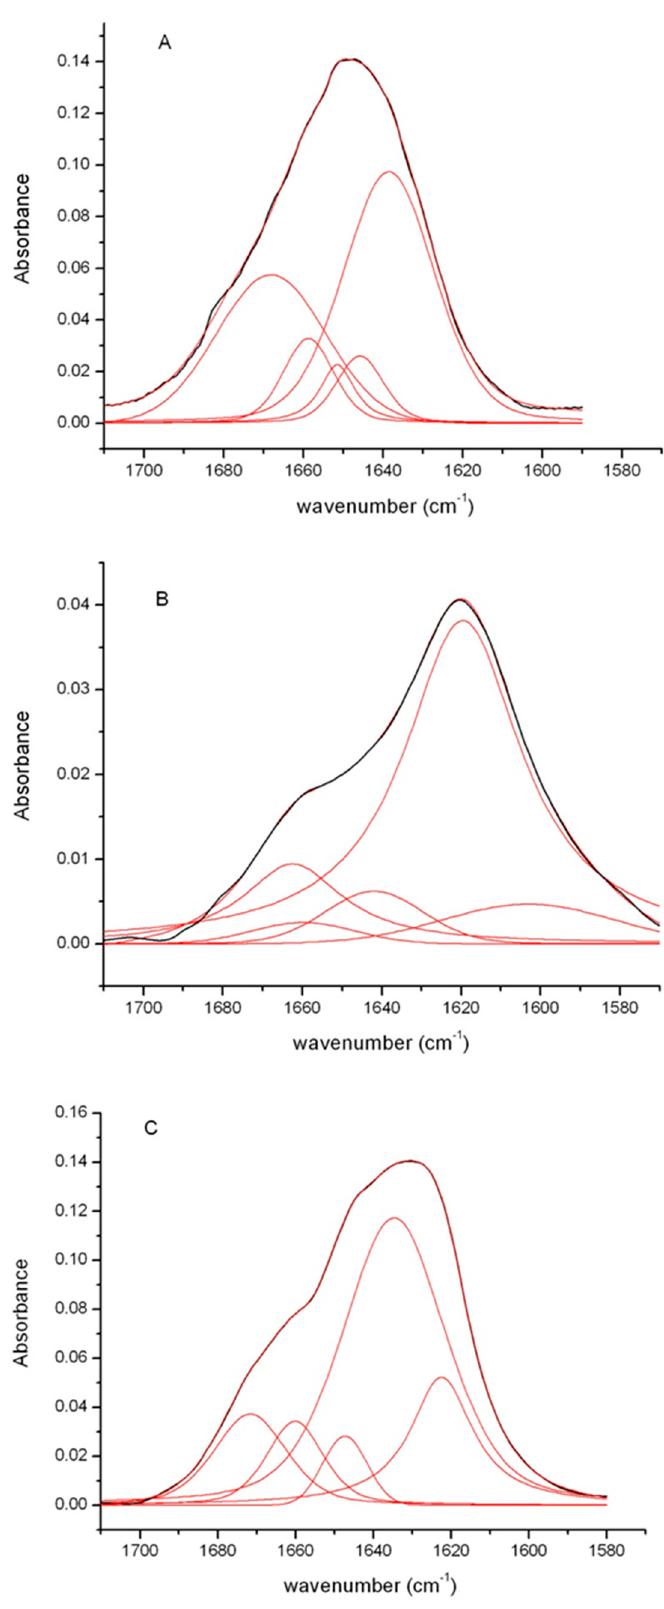
Figure 5. FTIR analysis of insulin fibrils. FTIR spectra of the human insulin after 24 h in aggregating conditions at pH 1.8 (panel B ) and pH 7.0 (panel C ), in comparison with the protein in native conditions (panel A ). In red are shown the results of the deconvolution analysis. Experimental details are described in the Materials and Methods section.